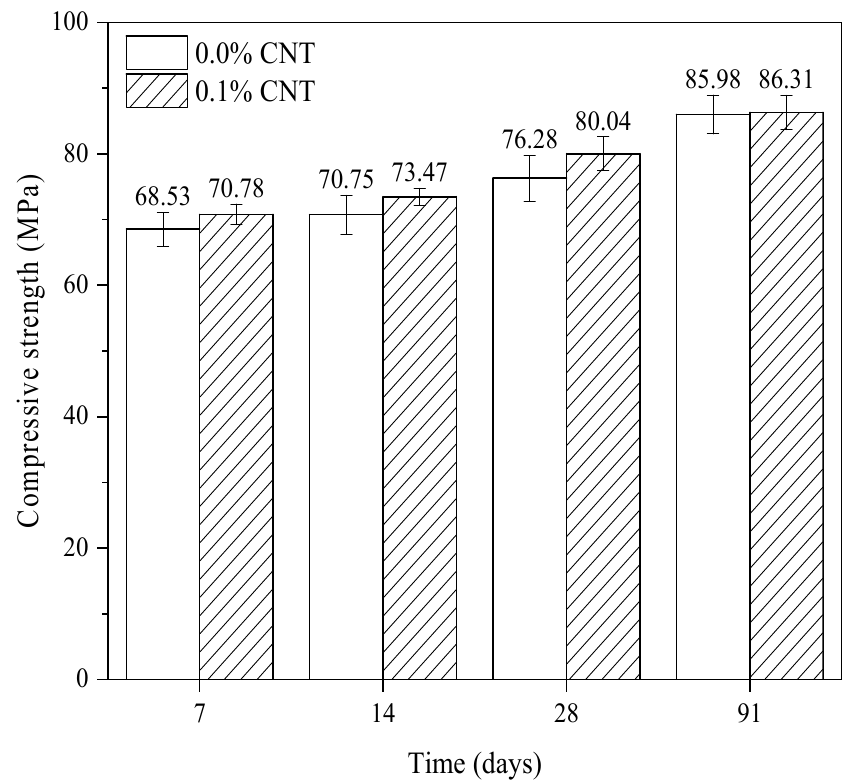
Figure 4. Compressive strength of cement pastes after 7, 14, 28, and 91 days.